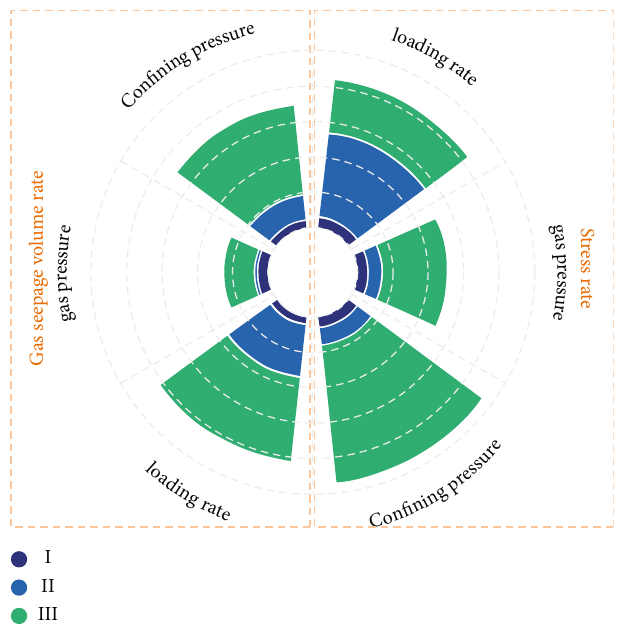
Figure 9: Percentage of crack propagation duration of coal under di ff erent stress states.